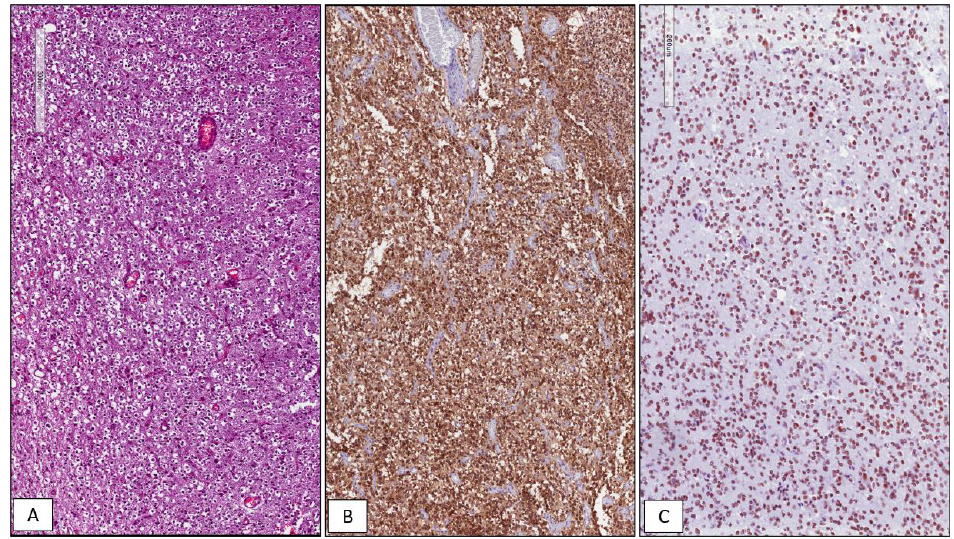
Figure 2. WHO grade II IDH mutant and 1p/19q co-deleted oligodendroglioma. Histopathological examination showing a moderately cellular glial tumor, composed of bland-looking round